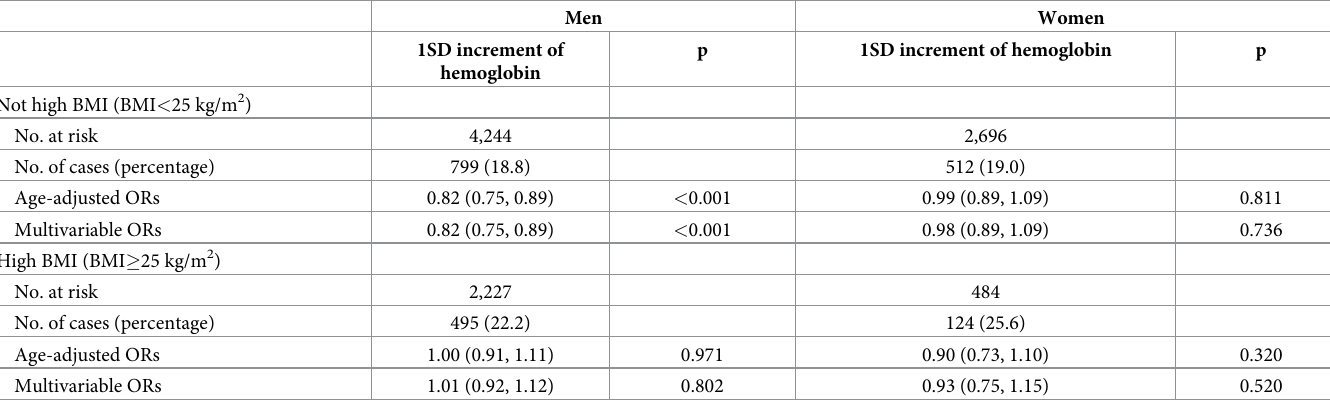
To assess sensitivity, we performed the main analyses again with height loss defined as the highest quartile of height decrease per year. We obtained essentially the same results. Table 3. Odds ratios (OR) and 95% confidence intervals (CI) for height loss in relation to hemoglobin by BMI status.